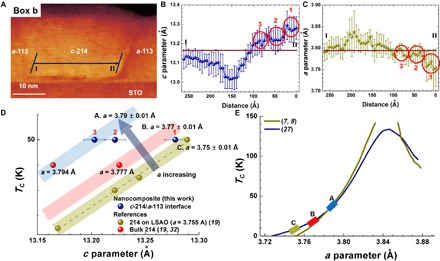
Structural analyses of 214:113.(A) STEM image of the c-214/a-113 boundary within white dashed Box b in Fig. 3 (C and D). The blue arrow from points I to II shows the horizontal distance where the lattice parameters were analyzed. The out-of-plane lattice parameters of the film were analyzed along the slanted lines that run parallel to the boundary and then averaged. (B and C) Lateral variation of the lattice parameters across the region from points I to II. The bars on each point reflect the variation in lattice parameters over the slanted regions in (A). The brown solid lines indicate the bulk lattice parameters of 214. (D) Relation of TC and c. The averaged c values from regions 1, 2, and 3 in (B) and (C) are included in (D), as well as the data for bulk 214 (oxygenated and Sr-doped) and 214 films grown on LSAO substrates from (19, 32). The projected influence of a on the plot [as determined from (E)] is shown schematically by the blue arrow. The yellow dashed line is a guide for 214 on LSAO (19). Yellow, red, and blue zones have the same slope as the guide for 214 on LSAO but with different a. (E) Maximum TC versus a (7, 8, 27) for optimized cuprates. A strong dependence of TC on a (and hence the in-plane Cu-O distance) is observed with a peak in TC at a ~ 3.84 Å (7, 8). Zones A, B, and C from (D) are included on the plot to show the good fit of the experimental data of this work to the “model” plot.